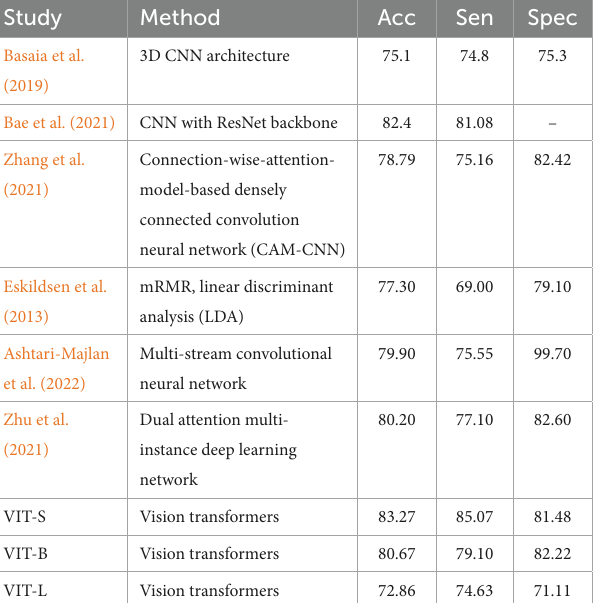
TABLE 2 Referential comparison between the proposed model with MRI- based studies for MCI progression prediction (in %).